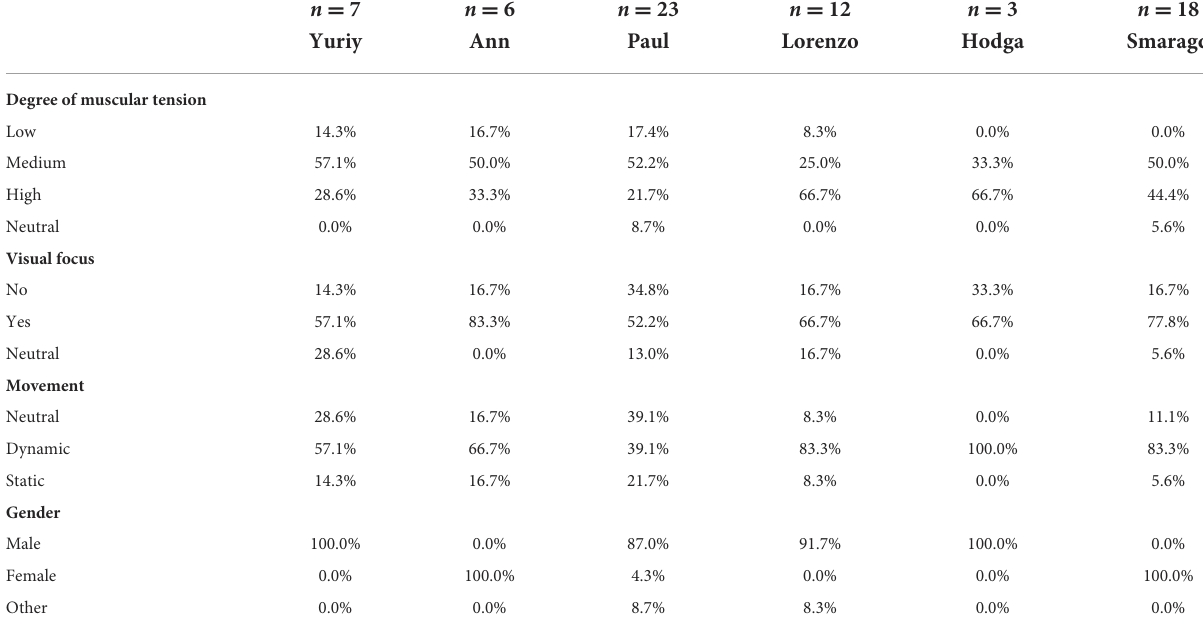
TABLE 5 Perceptions related to various character features ( n = number of responses for each character, % over responses for each level and character). n = 7